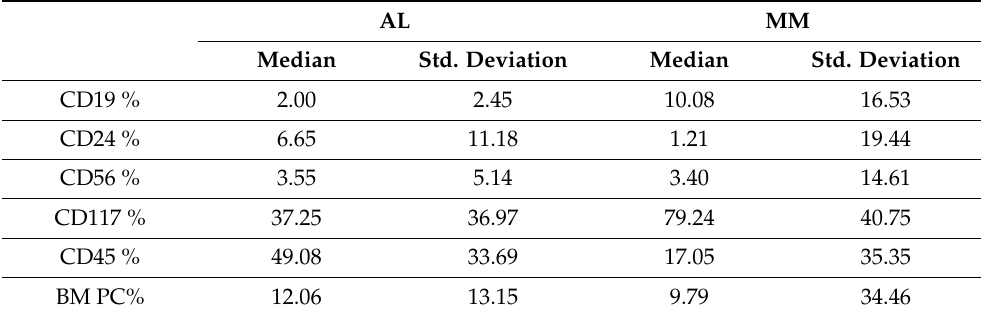
Table 2. Comparative prevalence of CDs in AL and MM ( p value = NS for all variables).